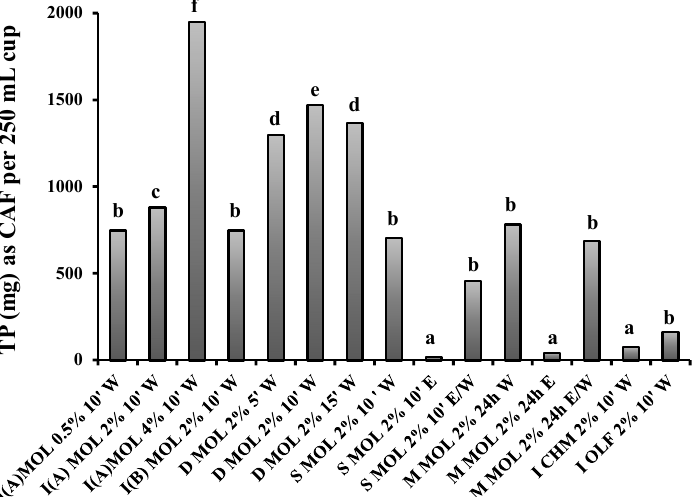
Figure 1. Total phenols (TP) content of herbal preparations expressed as mg caffeic acid (CAF) per 250 mL cup (p < 0.05); in section 2.3 details for sample names are provided. Material to solvent ratio affected the TP content of the examined MOL infusions (0.5, 2 and 4% w/v) in a linear manner. I(A) MOL 4% 10’ W held a double TP content (1949 ± 163 mg TP as CAF